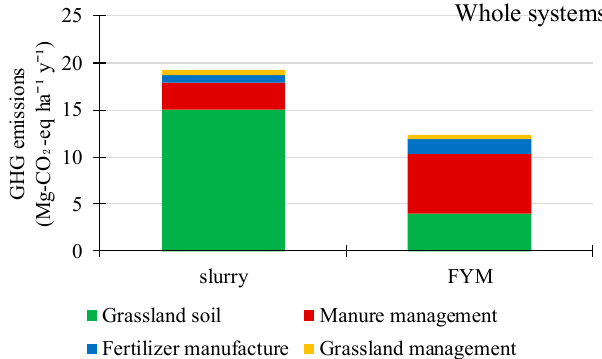
Figure 3. Annualized overall net GHG ( greenhouse gas ) emissions from herbage production.